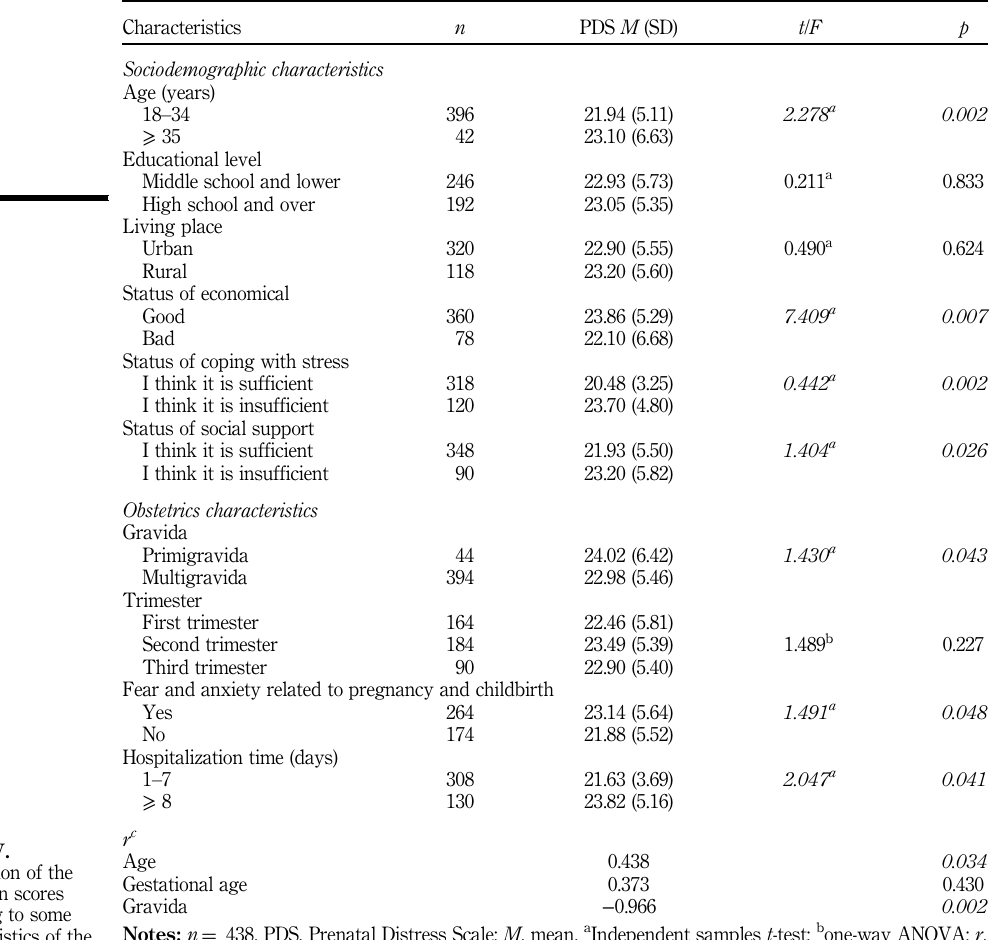
Table IV. Distribution of the PDS mean scores according to